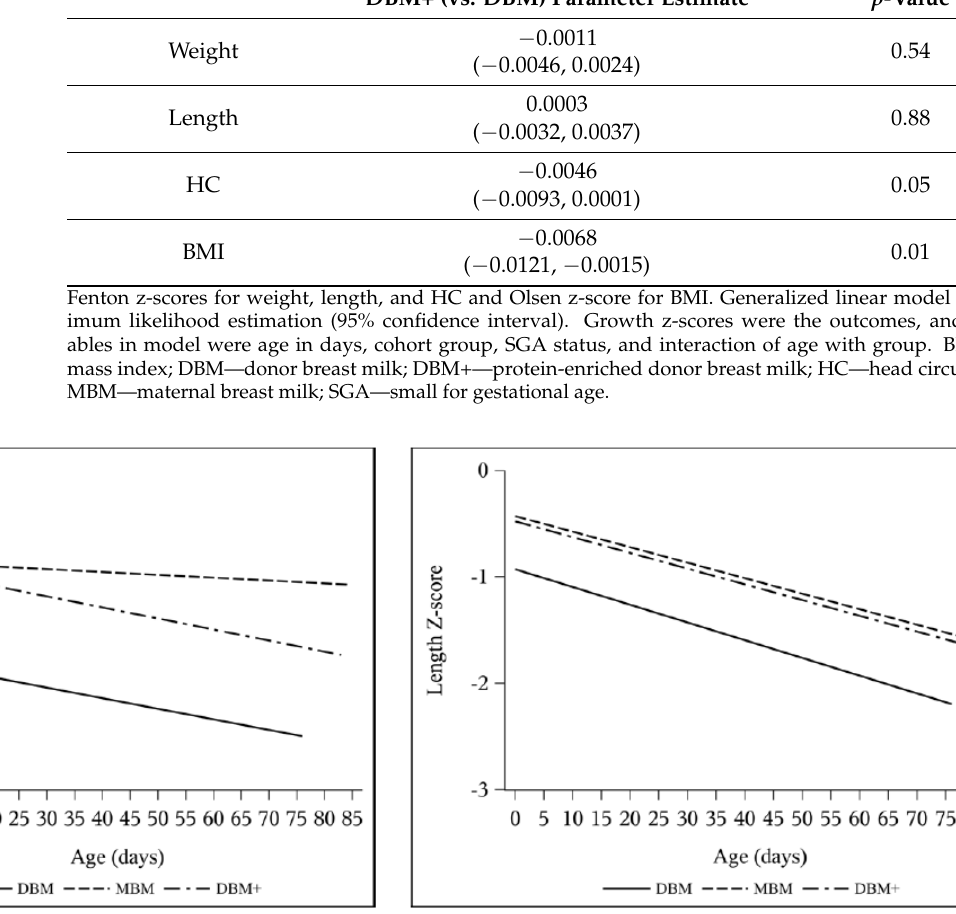
Figure 3. Unadjusted longitudinal models of z-score change over time for Fenton weight, length, and HC and Olsen BMI by cohort: DBM ( n = 58), MBM ( n = 64), DBM+ ( n = 59).